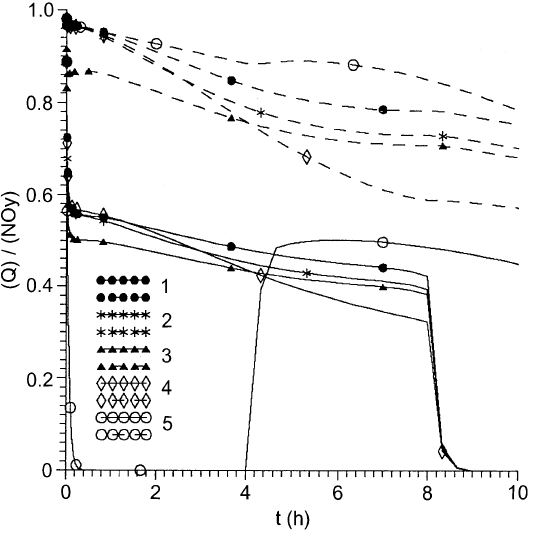
Fig. 9. Same as in Fig. 7 but for HNO (cid:50) evolution